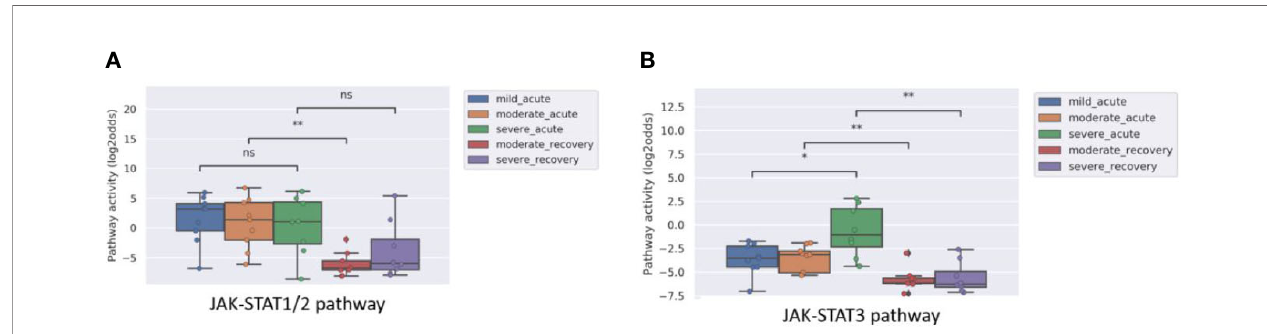
FIGURE 2 | JAK-STAT1/2 (A) and JAK-STAT3 (B) pathway activity analysis of dataset GSE69606 (35) including patients with acute RSV infections, divided into mild, moderate and severe disease. From moderate and severe diseased patients, recovery samples (on average 4 weeks after discharge) were also available. Peripheral blood mononuclear cells (PBMCs) were used for analysis. Pathway activity score on Y-axis in log2odds. Two sided Mann – Whitney – Wilcoxon tests were performed; mild_acute vs servere_acute, moderate_acute vs moderate_revovery and severe_acute vs severe_recovery; p-values are indicated in the fi gures as *p < 0.05, **p < 0.01, or ns (not signi fi